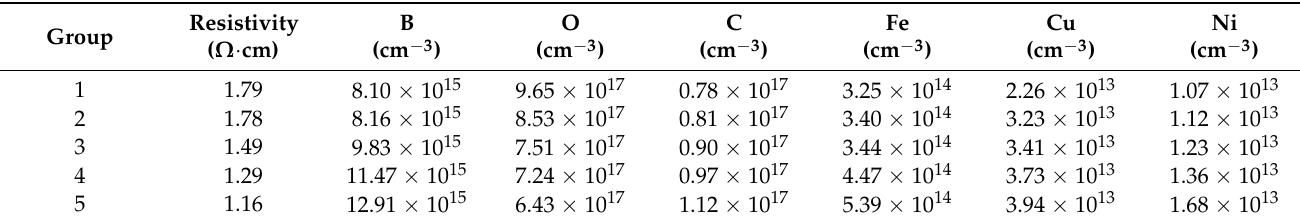
Table 1. The average resistivity as well as average contents of B, O, C, Fe, Cu and Ni of the five groups of Cz-Si